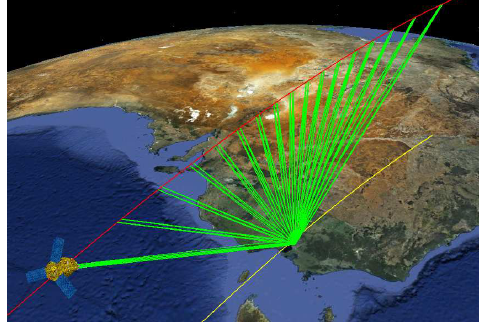
Figure 13: example of video acquisition mode over Melbourne Revisit